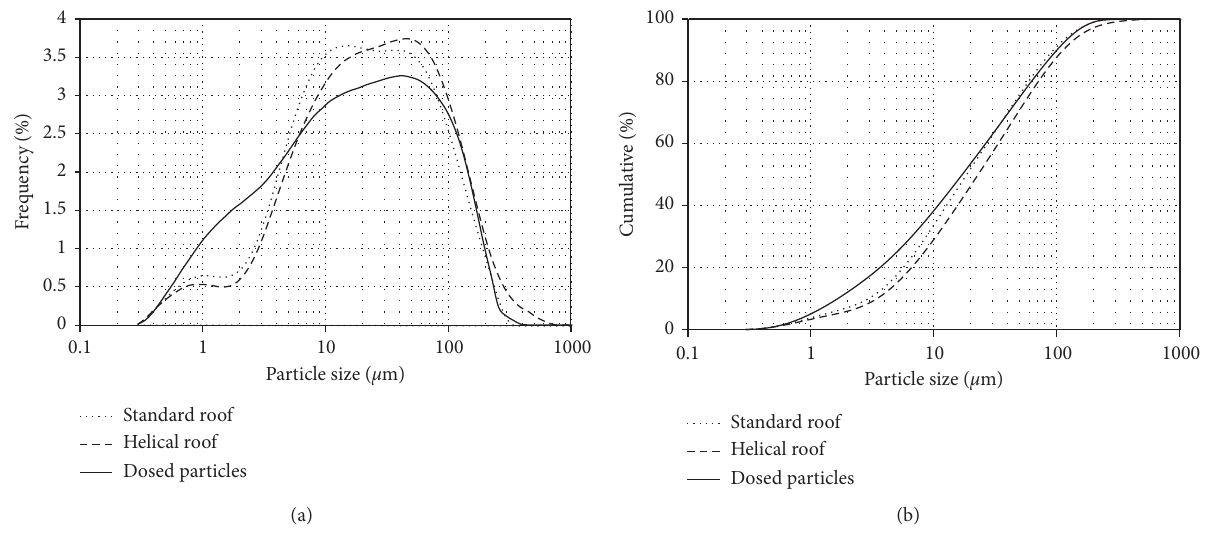
Figure 4: Size distributions of injected collected particles (a) frequency distribution and (b) cumulative distribution.